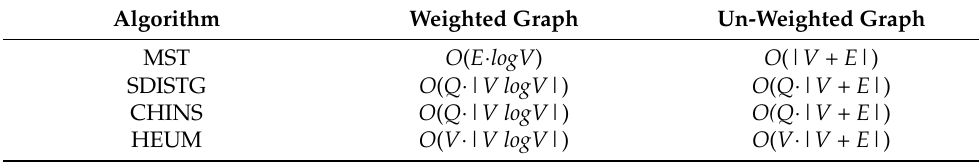
Table 4. Worst-case complexities for linking the most important nodes in a graph.